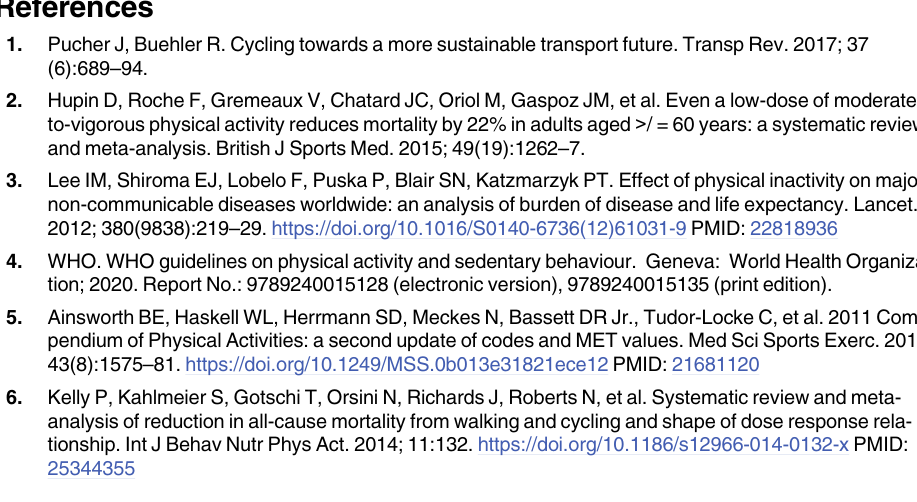
S2 Fig. Creation and definition of outcomes and respective reference categories. S1 Table. Results of interaction